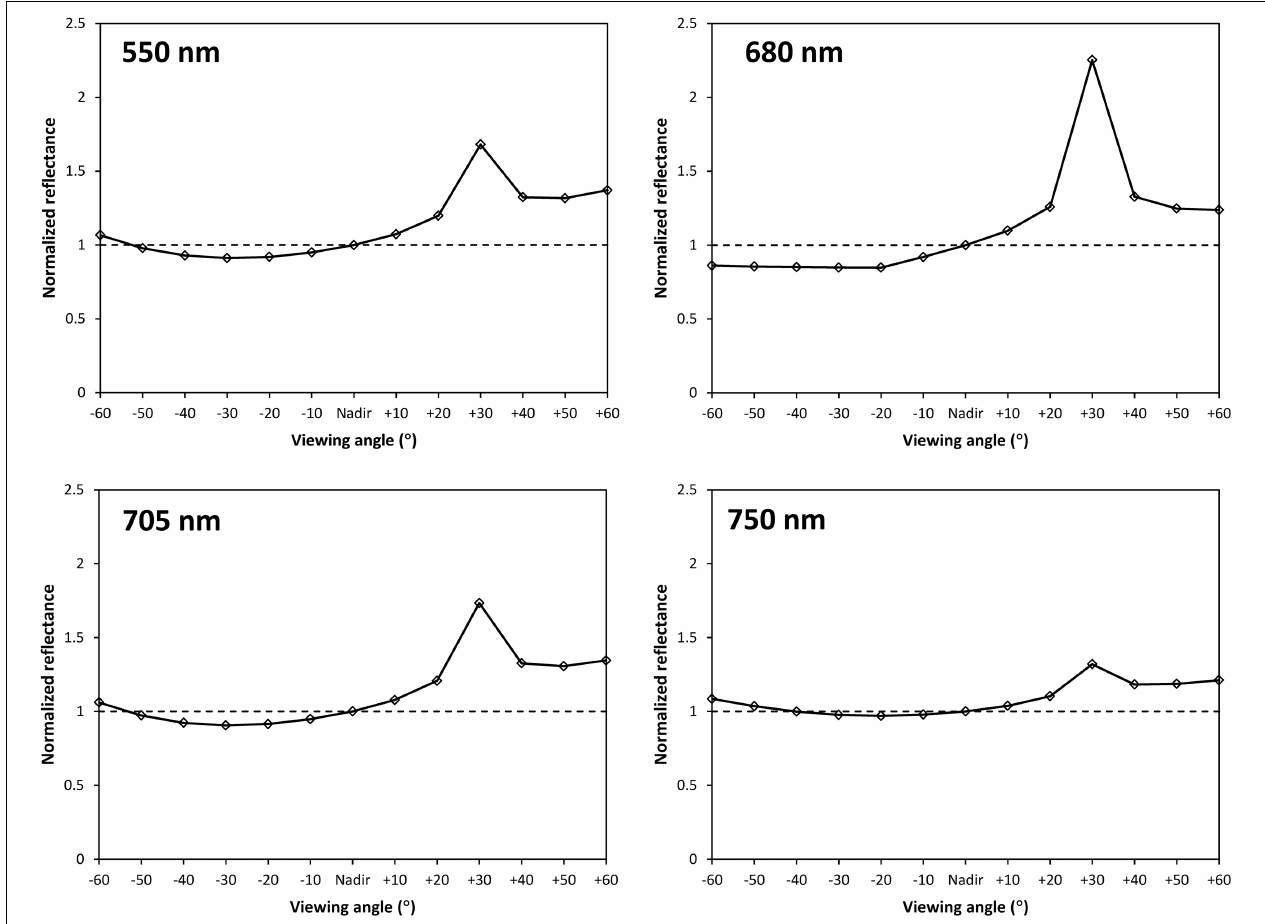
FIGURE 3 | The curves of normalized reflectance at different viewing angles for green (550 nm), red (680 nm), red edge (705 nm), and NIR (750 nm) bands. The viewing angles varied from –60 ◦ to +60 ◦ with 10 ◦ incremental steps, where a positive angle refers to the back-scattering direction, a negative angle refers to the forward-scattering direction. The dash lines indicate normalized reflectance = 1, where the reflectance was measured from the nadir direction.